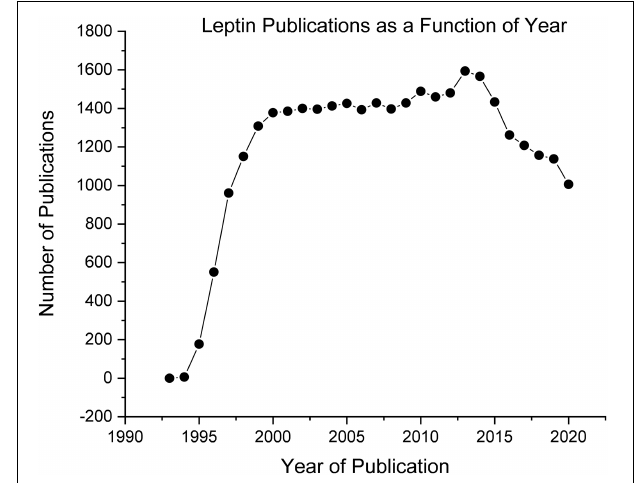
FIGURE 2 | Leptin publications as a function of year obtained from